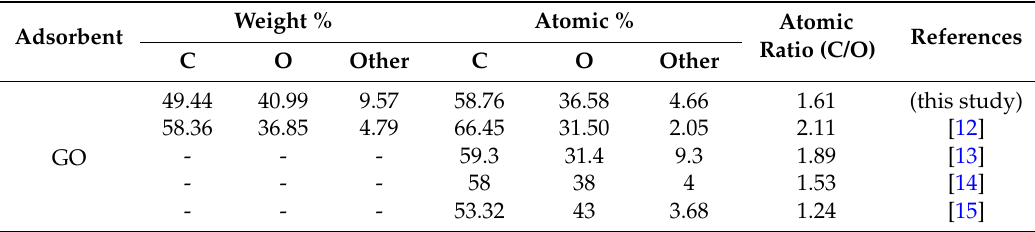
Table 1. Comparison of the elemental analysis of graphene oxide (GO) measured by scanning electron microscopy with energy dispersive X-ray spectroscopy (SEM/EDS) with the results of previous studies.